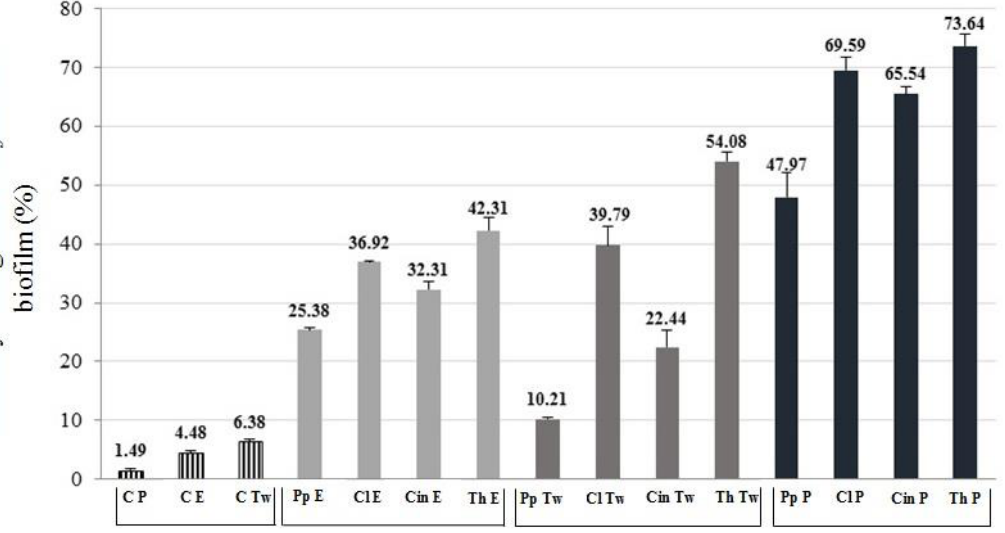
Figure 3. Biofilm inhibition activity of different formulated EOs against Haemophilus influenzae . C —